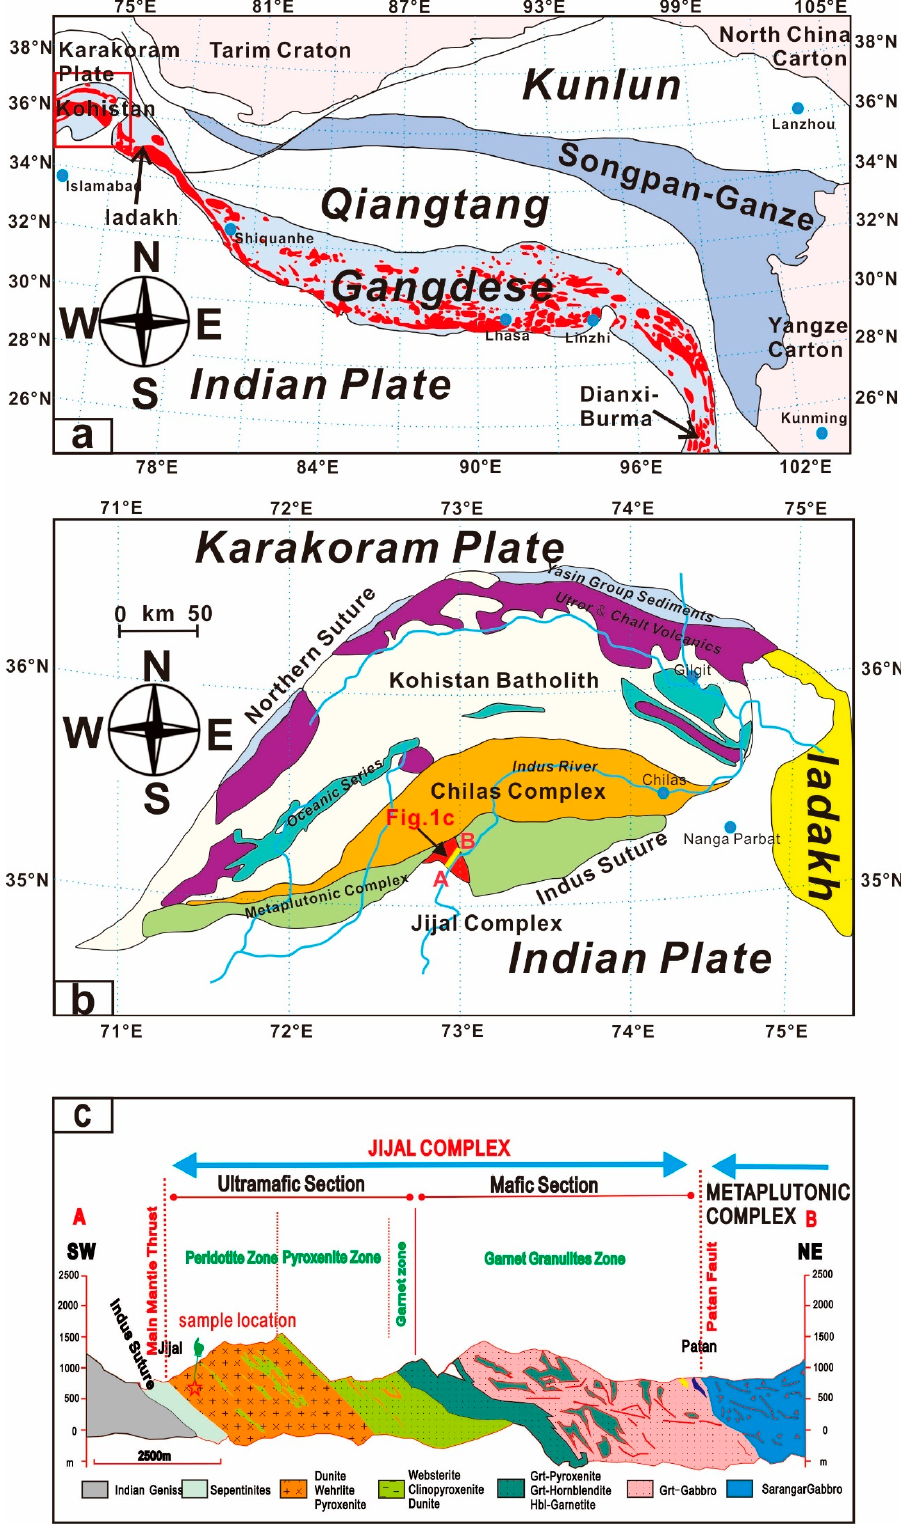
Figure 1. ( a ) Distribution map of the Transhimalayan batholith (modified after Ji et al. [18]); ( b ) Simplified geological map showing the location of the Jijal complex of the Kohistan island arc complex, northern Pakistan (after Burg et al. [1]); ( c ) Geological section of the Jijal mafic–ultramafic complex (modified after Burg et al.